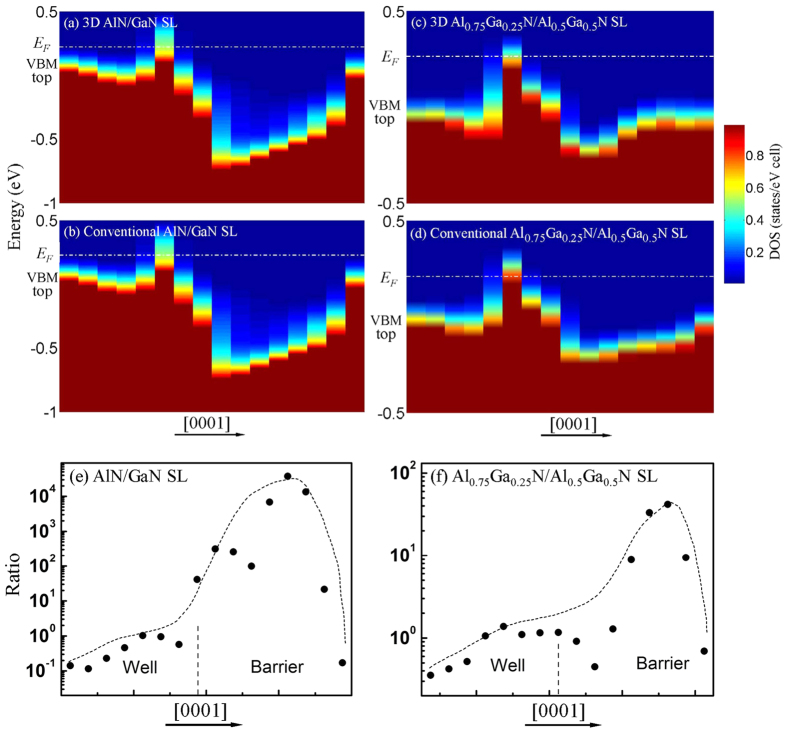
Projected DOS of valence bands along the [0001] direction for each bilayer in Mg-doped 3D and conventional SL (a–d). Hole concentration ratio of 3D SL to conventional SL for AlN/GaN (e) and Al0.75Ga0.25N/Al0.5Ga0.5N (f).